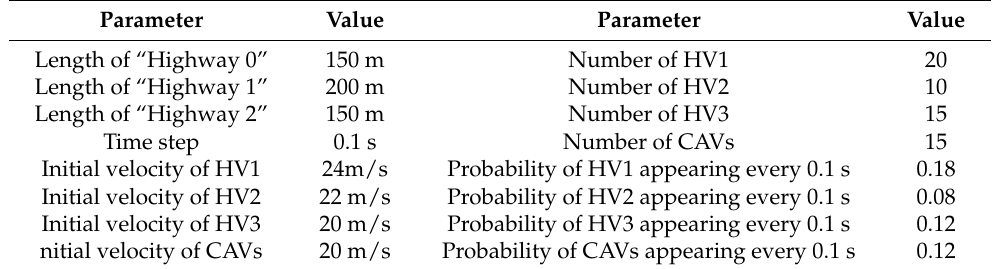
Table 1. Specific scenario setting